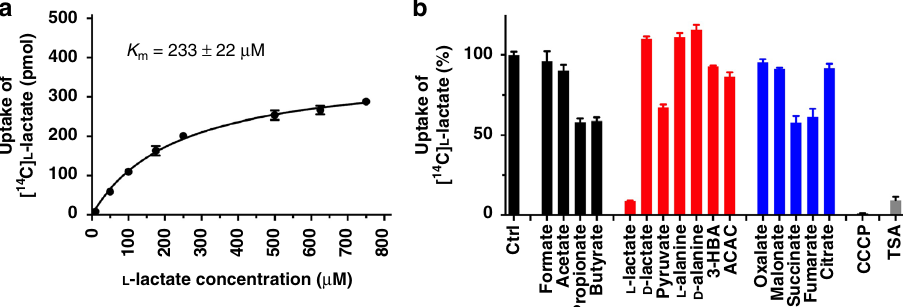
Fig. 1 Functional characterization of SfMCT. a Concentration dependence of SfMCT-mediated [ 14 C] L -lactate uptake into E. coli JA202 15 . A representative saturation curve with Michaelis – Menten equation fi t is shown. Data are represented as mean ± SEM from triplicates. An average K m of 233 ± 22 μ M was calculated from three independent saturation experiments, each in triplicate. b Determination of the substrate speci fi city of SfMCT by [ 14 C] L -lactate transport competition assay (1 mM fi nal concentration). Molecular structures of the used physiologically relevant compounds are shown in Supplementary Fig. 2. Residual uptake in the presence of competitor is normalized with respect to control samples without competitor (ctrl). Ketone bodies (R)-3- hydroxybutyrate and acetoacetate are abbreviated by 3-HBA and ACAC, respectively. Proton-dependence of the uptake was shown by 20 μ M of carbonyl cyanide 3-chlorophenylhydrazone (CCCP). Thiosalicylate is abbreviated by TSA. Data are represented as mean ± SEM from three independent experiments, each in triplicate. If not visible, error bars are smaller than symbols. Source data are provided as a Source Data